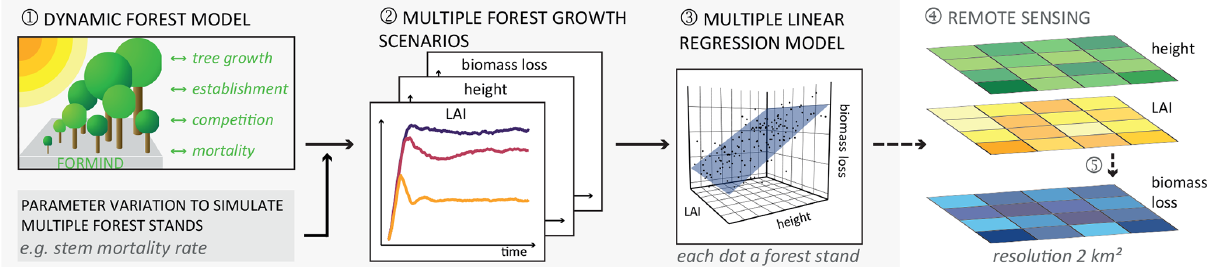
Figure 1. Framework developed for estimating biomass loss rates by linking a dynamic forest model and remote sensing. (1) A forest model was applied to (2) simulate the succession dynamics of forest stands of various forest attributes, such as LAI, forest height, and biomass loss rate, in a set of different stem mortality scenarios (results used to answer research question 1). A simulated forest stand has the area of 1ha, with the forest states of each simulated hectare differing at each simulation time step and scenario. (3) Then, we developed a multiple linear regression model for the simulated forest states with LAI and forest height as proxy variables and biomass loss rate as the response (results to answer research question 2). (4) In addition, we applied the multiple linear regression model to remote sensing maps containing the values of the investigated forest attributes (LAI and forest height) to (5) derive a sample map of biomass